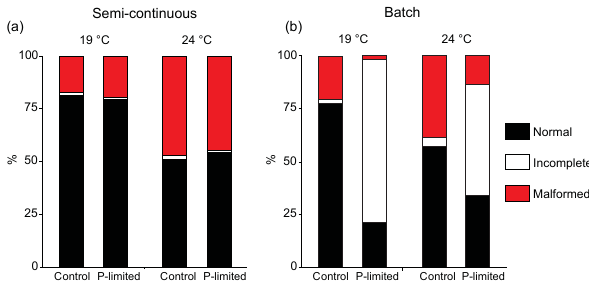
Figure 3. Coccolith morphology of Emiliania huxleyi grown at 19 and 24 ◦ C in control and P-limiting medium in semi-continuous and batch culture. Coccoliths were classified into the categories normal, incomplete and malformed; see Table 3, Fig.